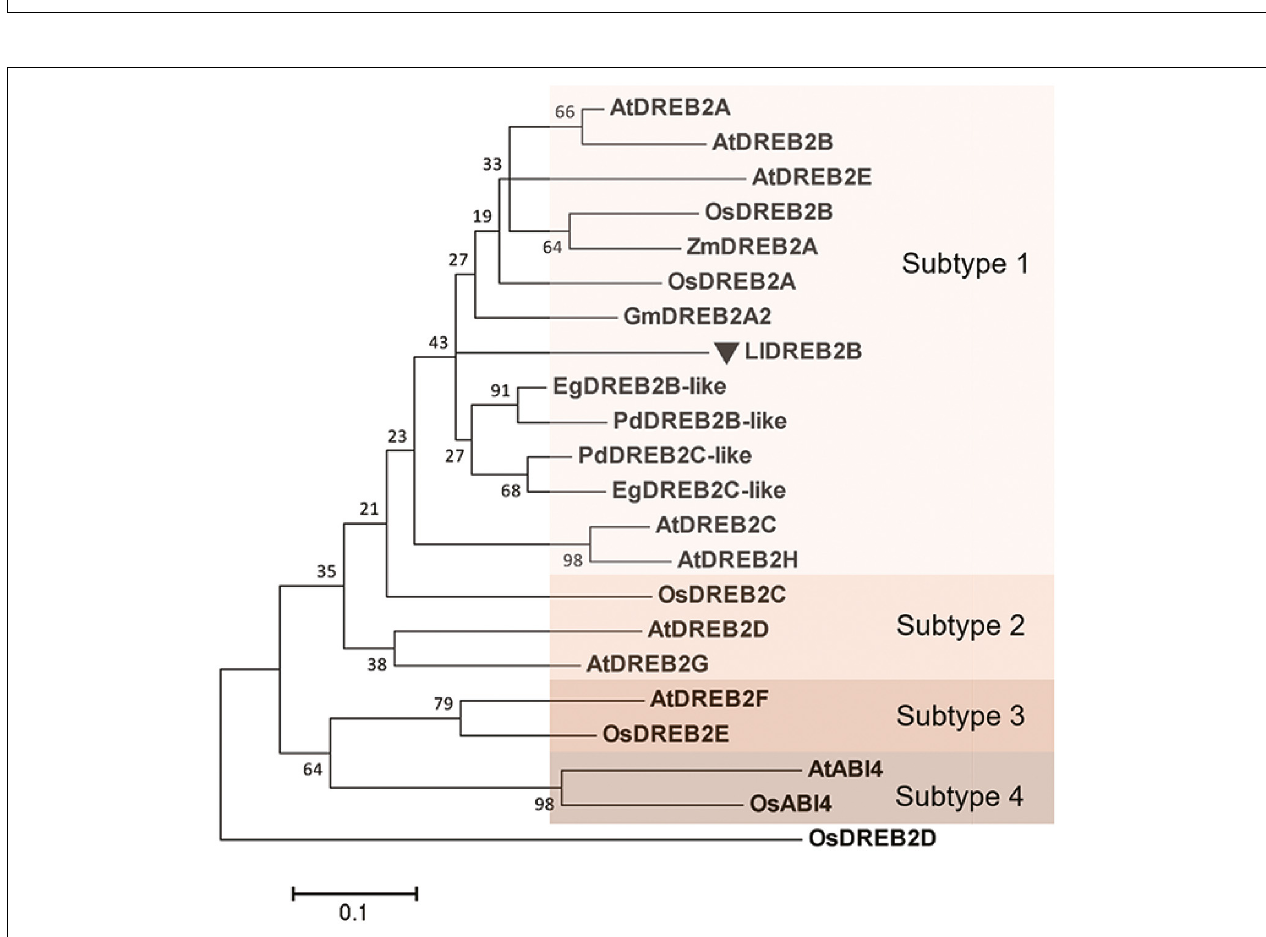
FIGURE 2 | Phylogenetic analysis of LlDREB2B and related proteins. Neighbor-joining tree based on alignment of the peptide sequences of the N-terminal conserved region and the DNA-binding domain (Supplementary Figure S3). Accession numbers are shown in Supplementary Figure S3. The tree was constructed using MEGA5.1. Numbers at nodes indicate bootstrap values from 1,000 replicates. Bar, substitution rate per site. Each subtype is indicated by a colored rectangle.